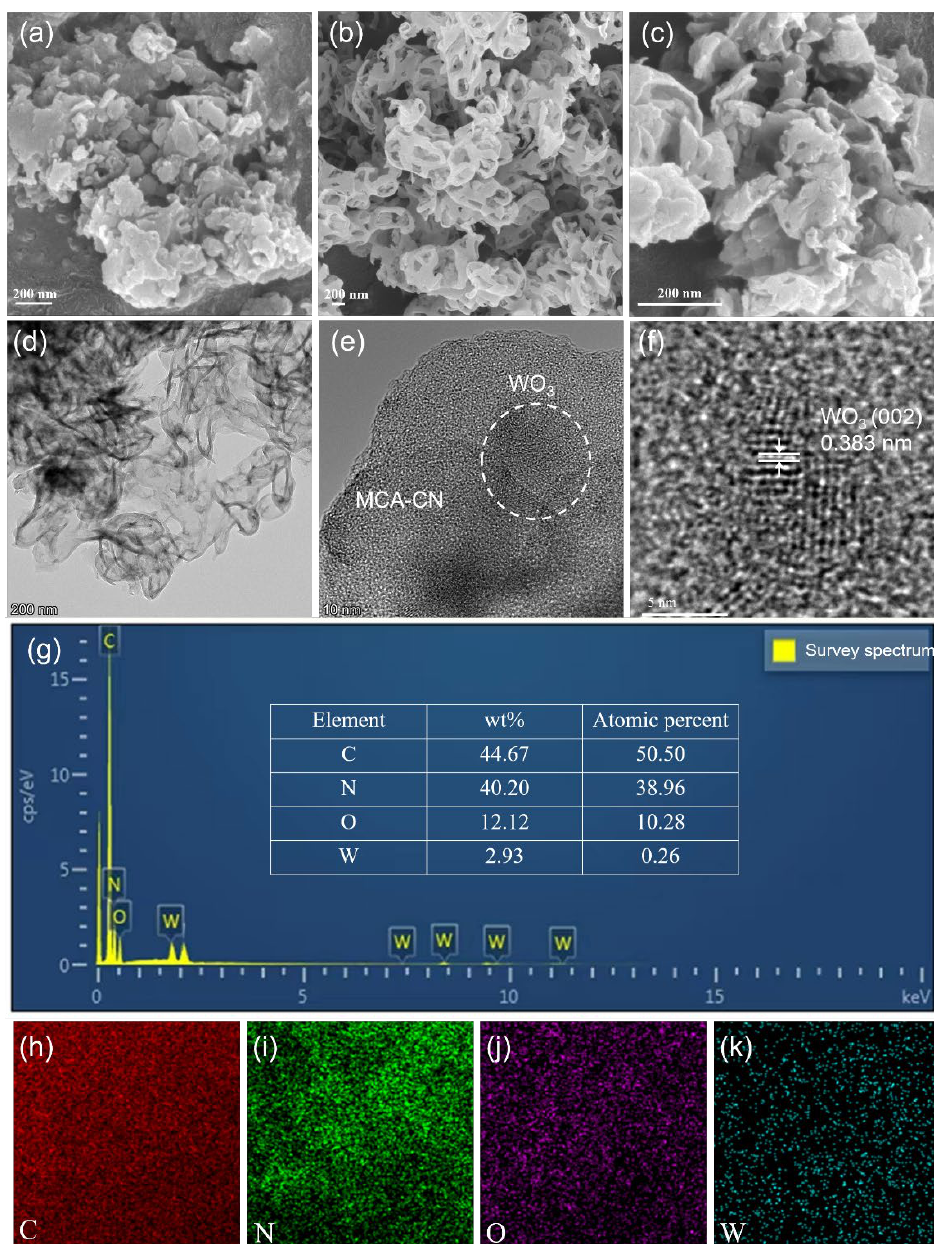
Figure 2. SEM images of ( a ) bulk CN; ( b ) MCA-CN and ( c ) MCA-CN/WO 3 . ( d – f ) TEM images of MCA-CN/WO 3 ; ( g ) survey spectrum of MCA-CN/WO 3 and ( h – k ) EDX spectrum and elemental mapping images of MCA-CN/WO 3 .